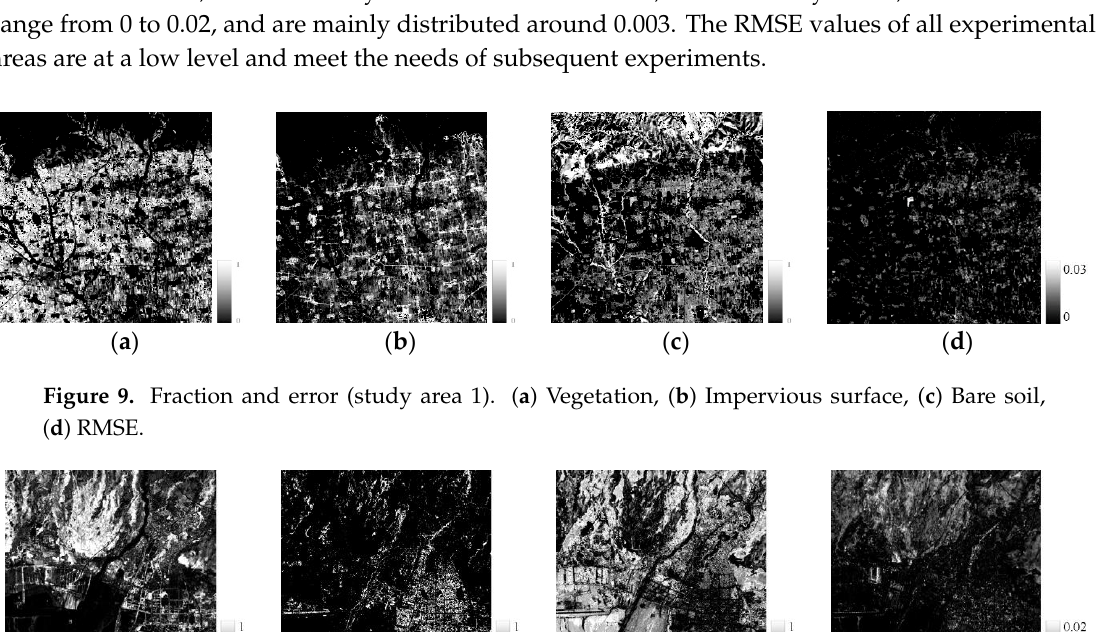
10 of 18 Table 1. Image data and acquisition time. Data Type